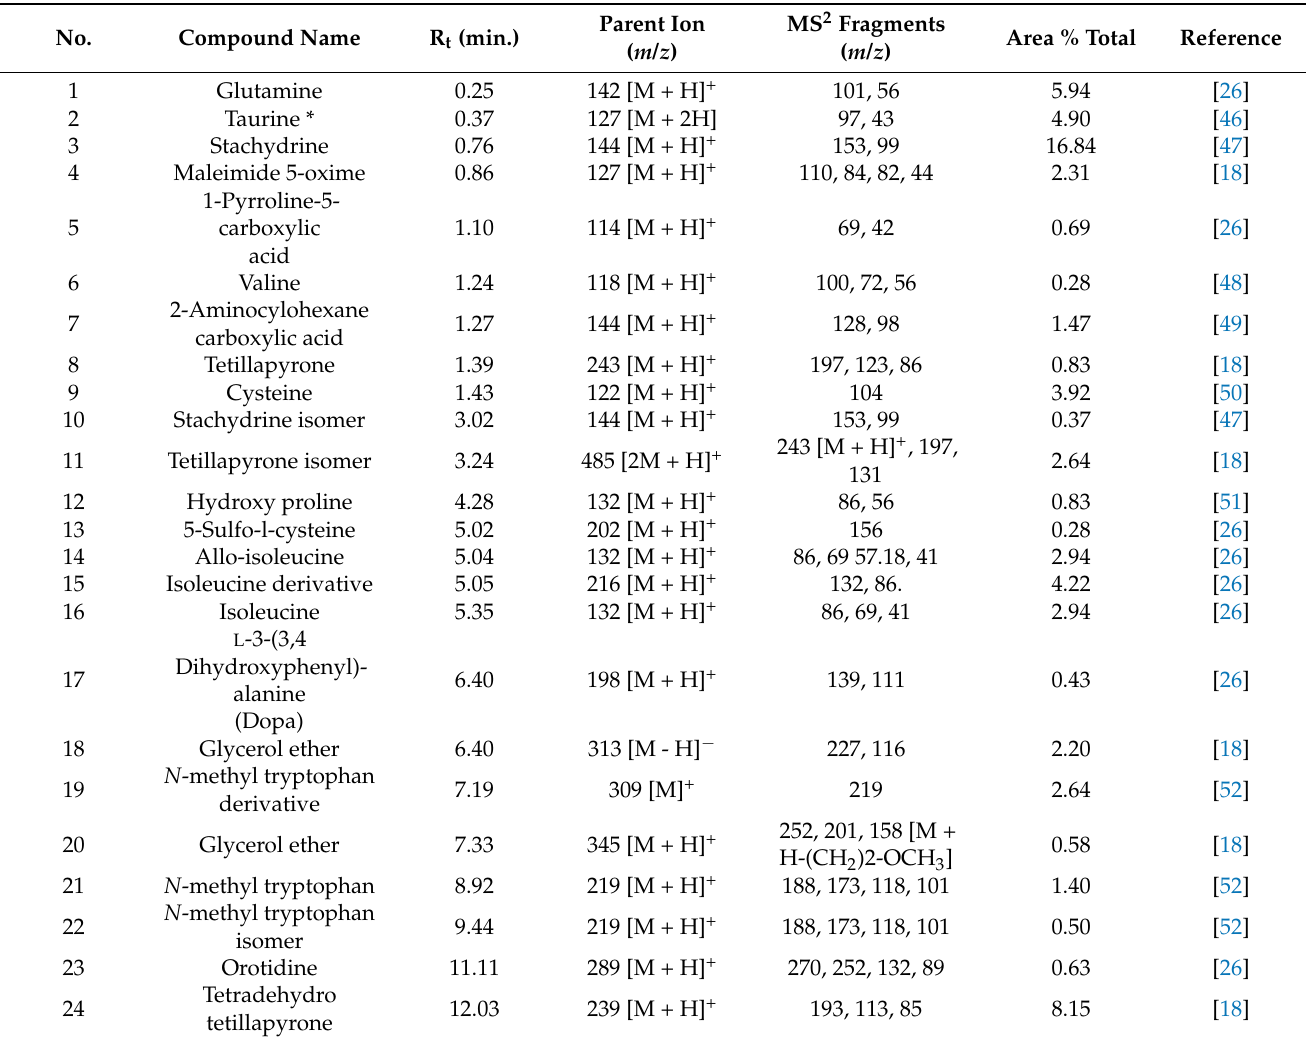
Table 3. Metabolites tentatively identified from ethyl acetate fraction using UPLC-ESI-MS/MS analysis in positive ionization